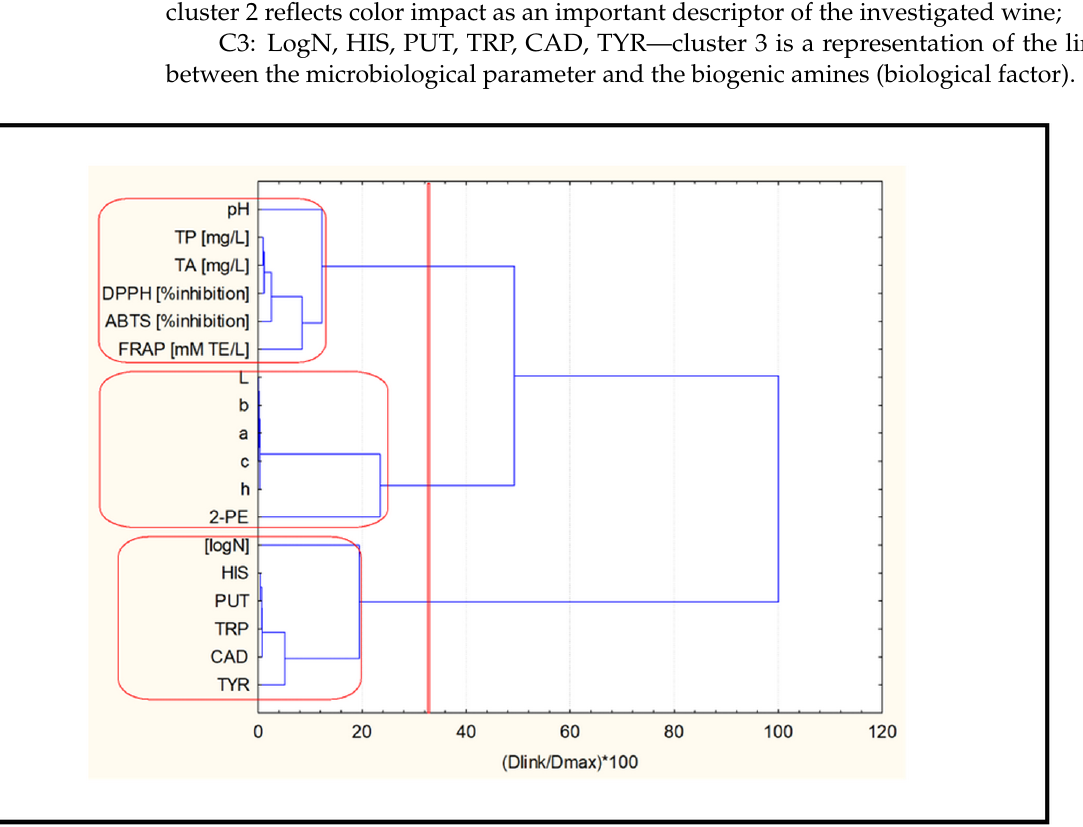
Figure 2. Hierarchical dendrogram for linkage of 18 variables. TRP—tryptamine; PUT—putrescine; HIS—histamine; TYR—tyramine; CAD—cadaverine; 2-PE—2-phenylethylamine.